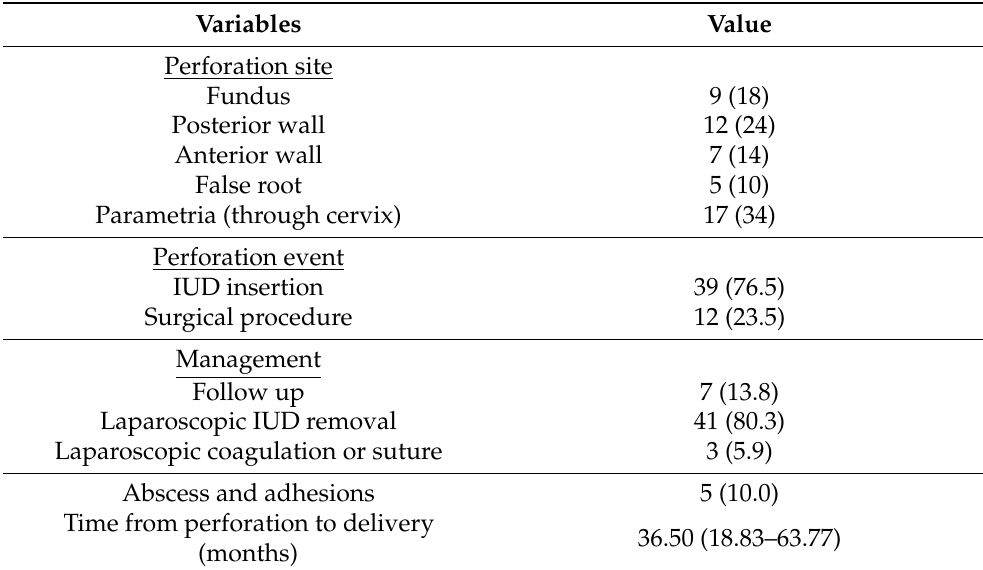
Table 2. Perforation characteristics and management data for patients who delivered following perforation of